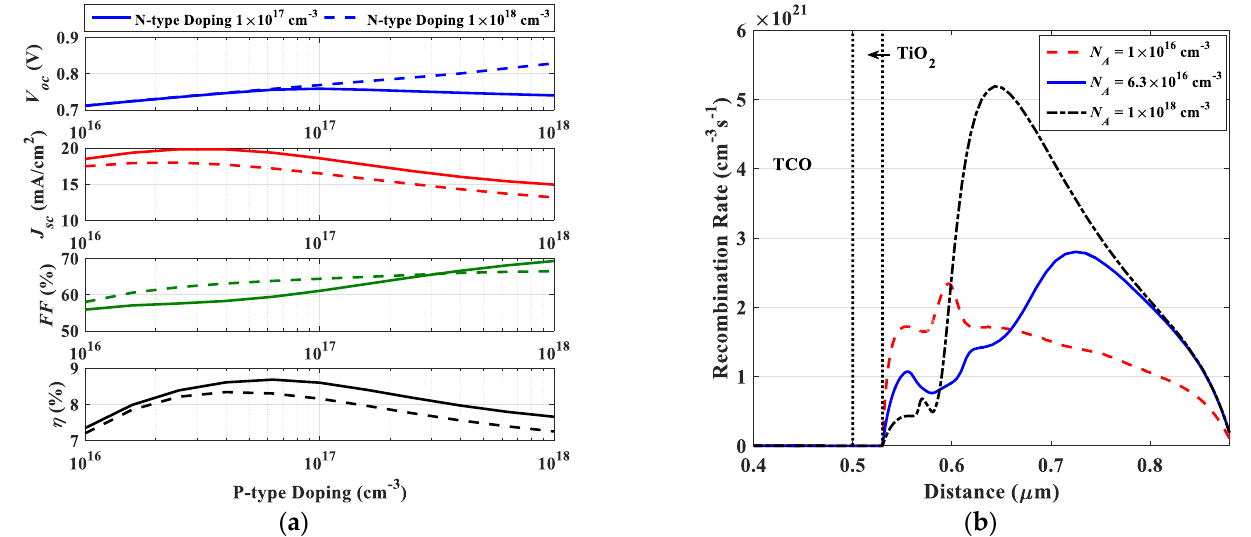
Figure 13. ( a ) Impact of p-layer doping variation on the HTL-free configuration photovoltaic parameters for two values of n-layer doping, and ( b ) recombination rates for three different values of p-layer doping.